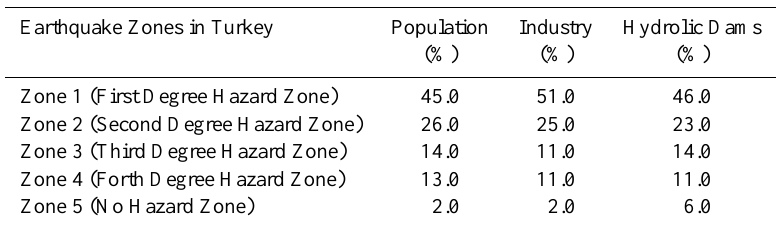
Figure 2c. Map showing the epicentre of the Kocaeli earthquake of August 17, 1999 and the location of industrial facilities (redrawn from Cruz [39])